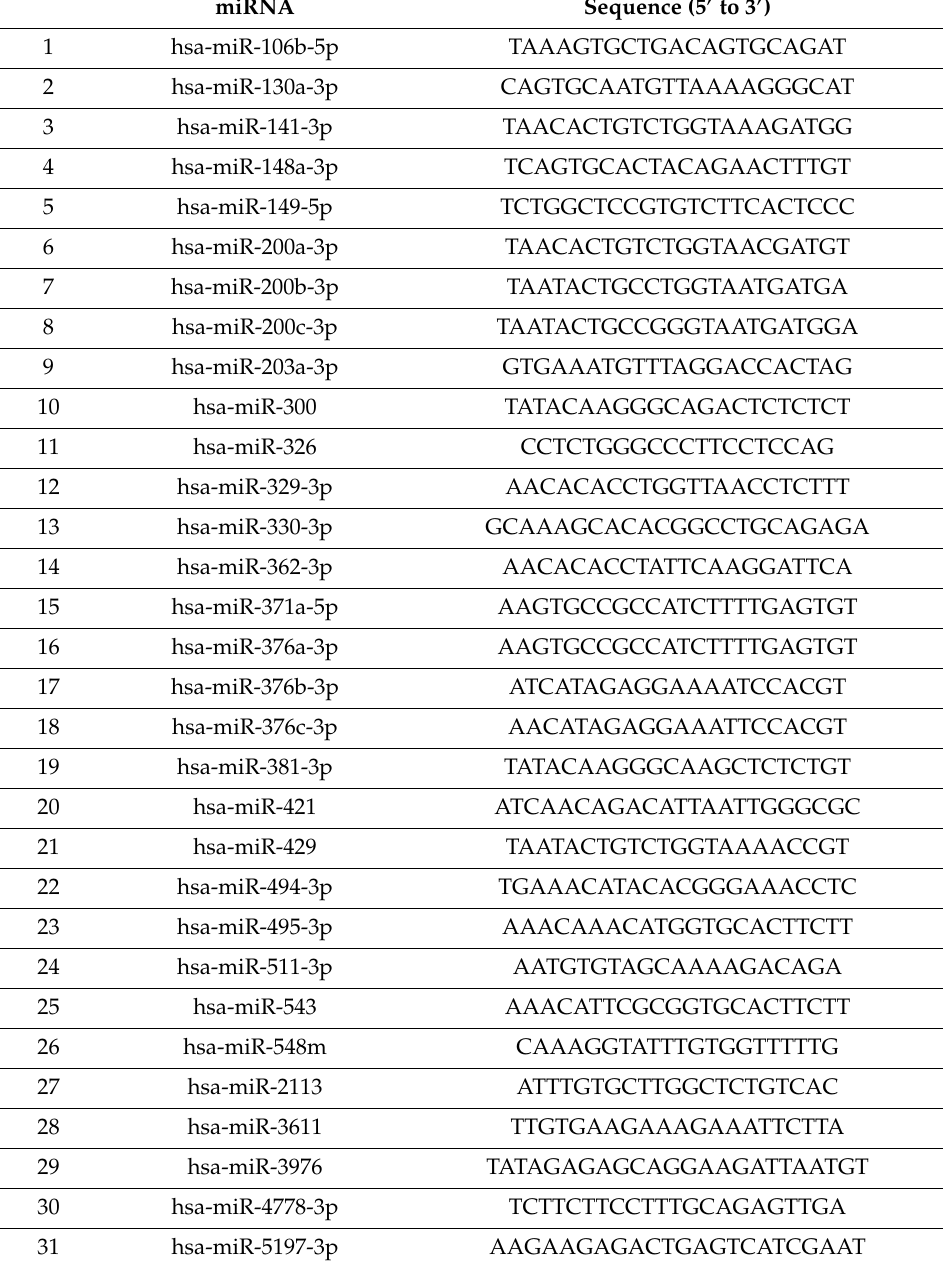
Table 1. List of miRNAs having strong binding potential against hACE2. ACE2, angiotensin-converting enzyme 2. miRNA Sequence (5 (cid:48) to 3 (cid:48)